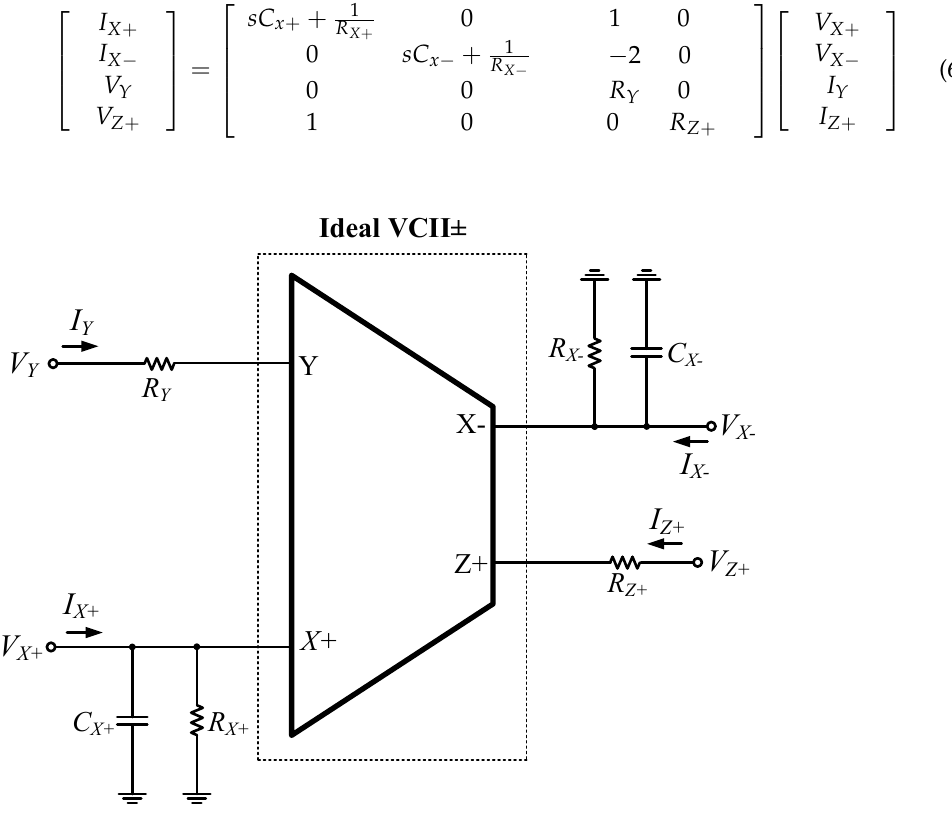
Figure 3. VCII± and its parasitic impedances. Figure 3. VCII ± and its parasitic